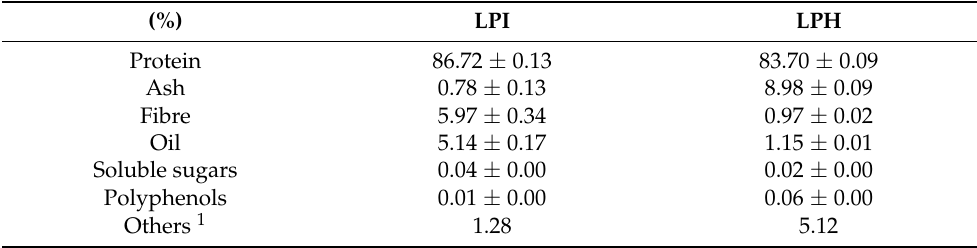
Table 1. Chemical composition of LPI and LPH. Data, expressed as percentage in dry basis, are mean ± standard deviation of three determinations.